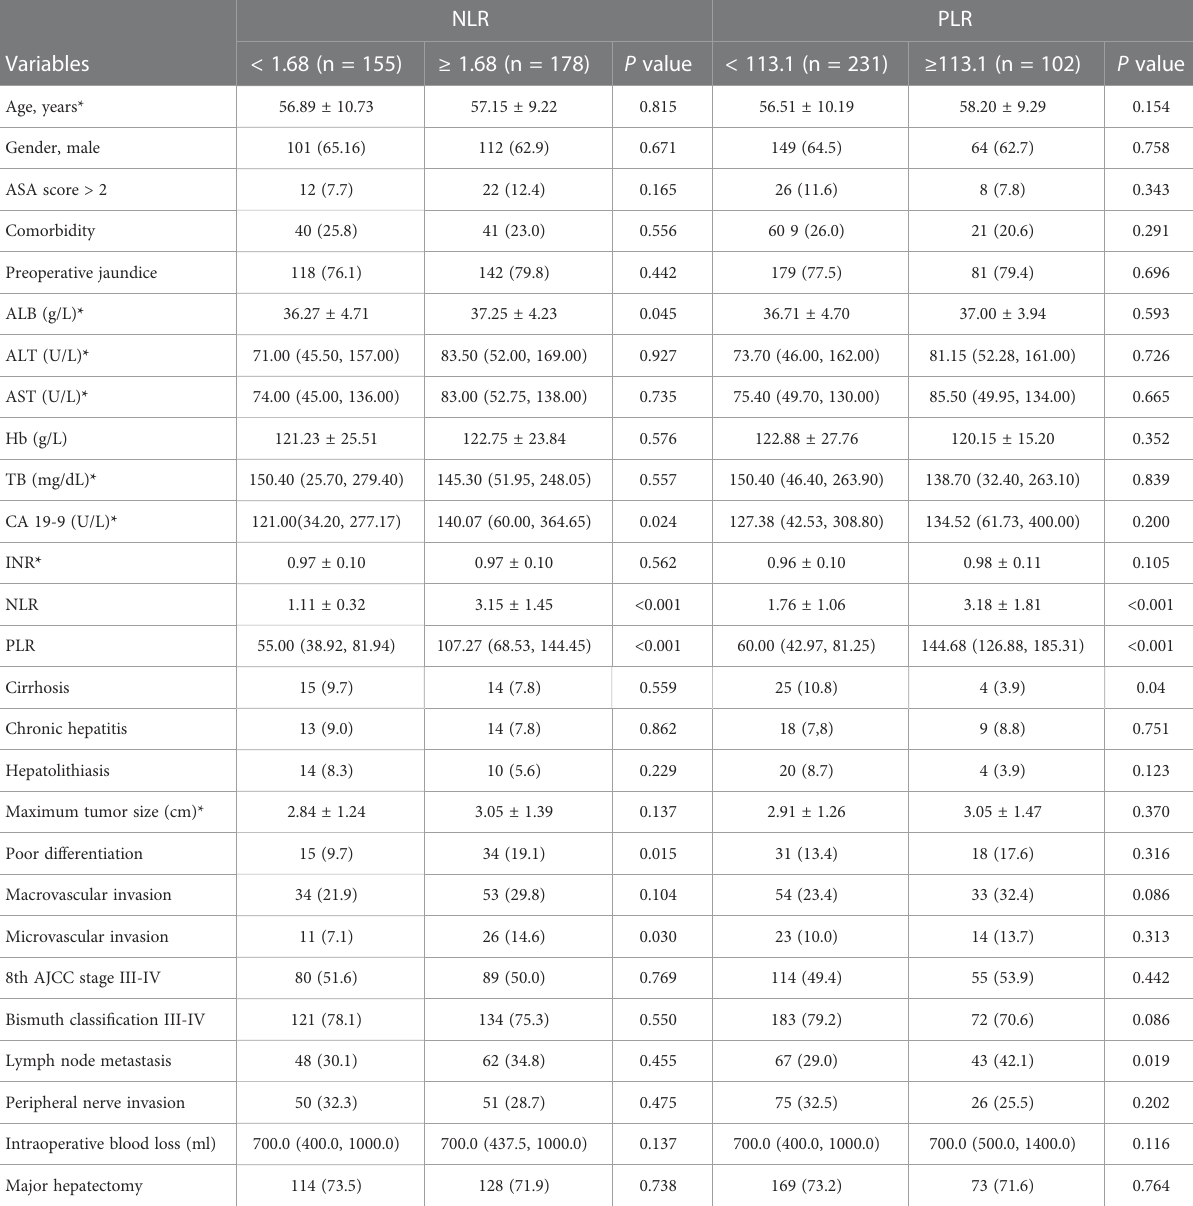
TABLE 1 Baseline for pCCA patients categorized by NLR, PLR and their clinical pathological characteristics.